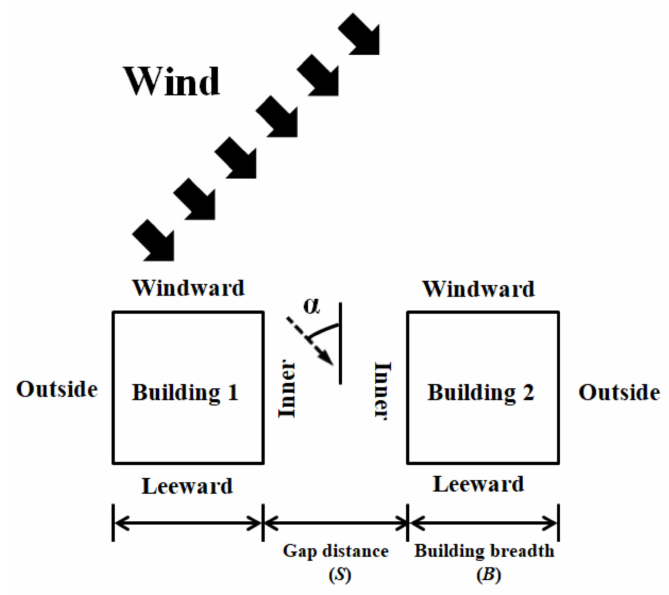
Figure 1. Surfaces in the building model and wind